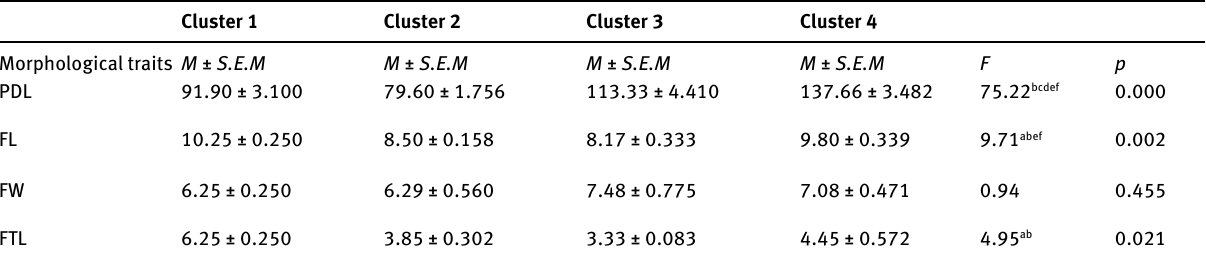
Table 1: Values (Mean ± S.E.M) of quantitative characters according to clusters with results of F tests and Tukey post-hoc analysis